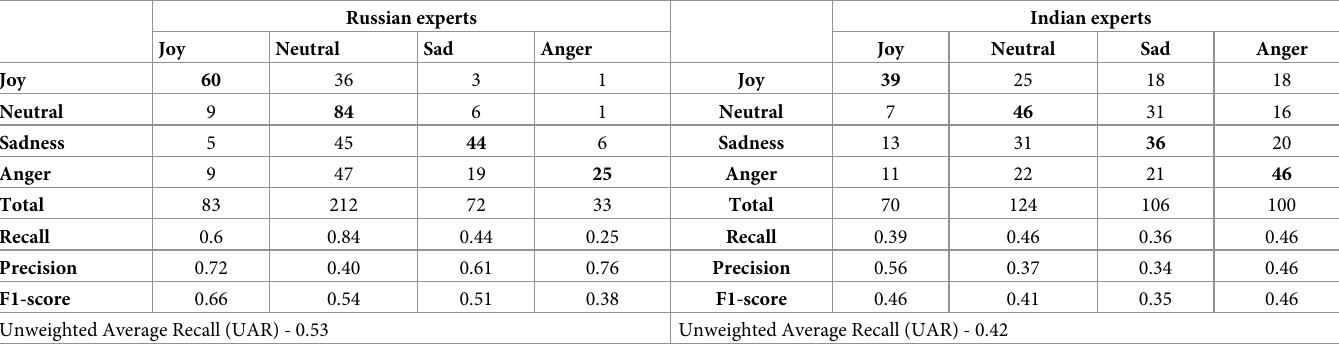
Unweighted Average Recall (UAR) - 0.53